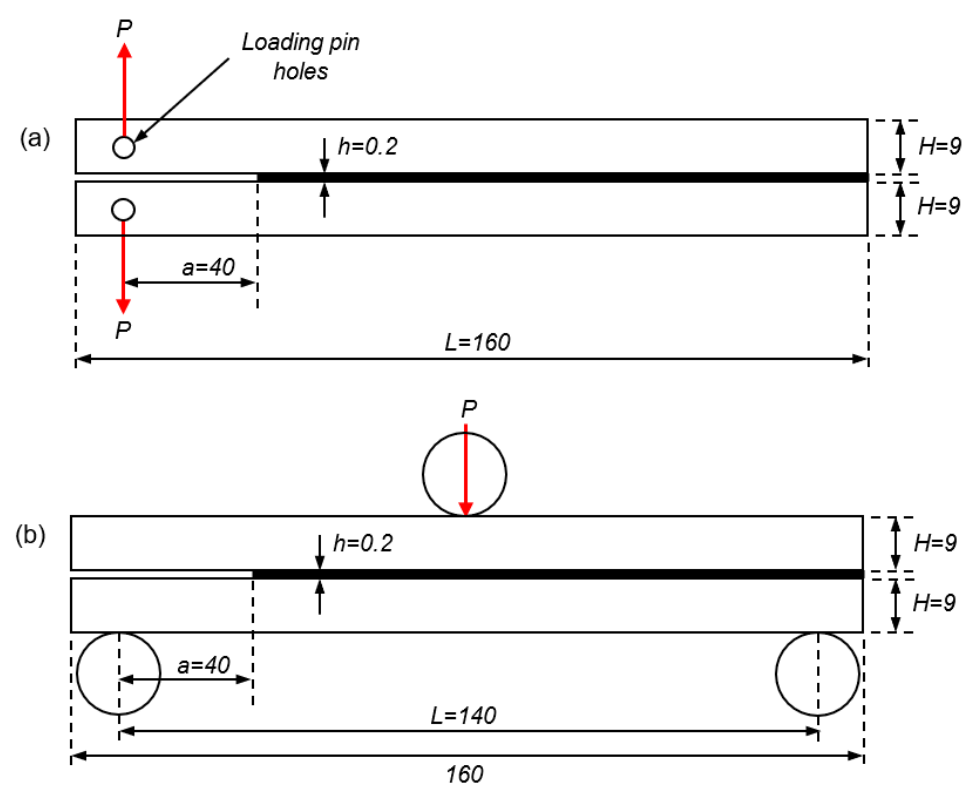
Figure 1. Specimen geometry for ( a ) the DCB test, and ( b ) the ENF test (dimensions in mm). Specimen breadth, b = 25 breadth, b =25 mm.